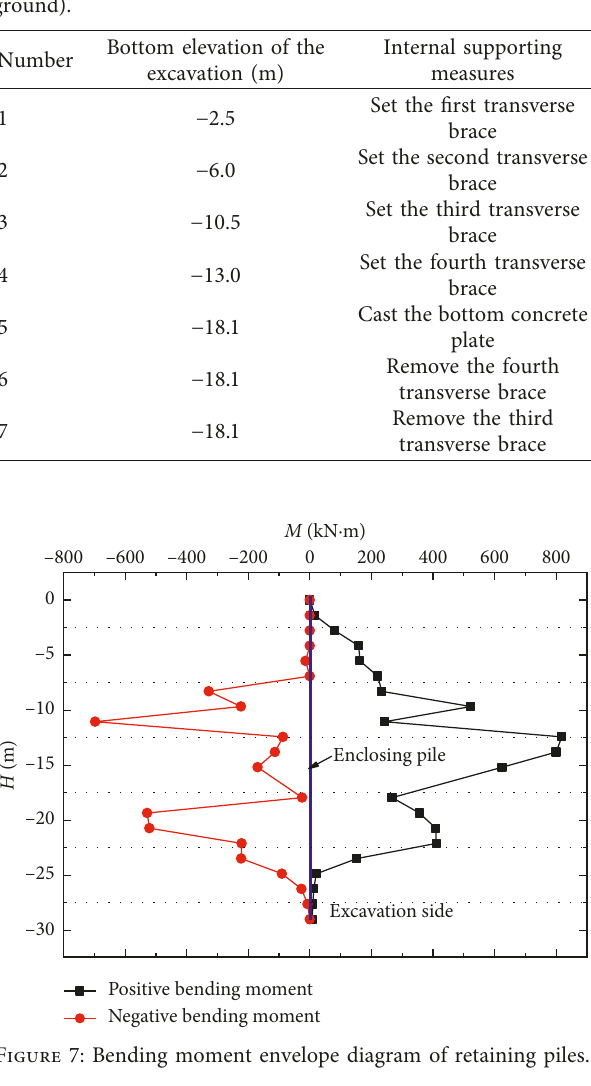
Table 3: Construction cycle of the foundation pit (0.0m is the ground).